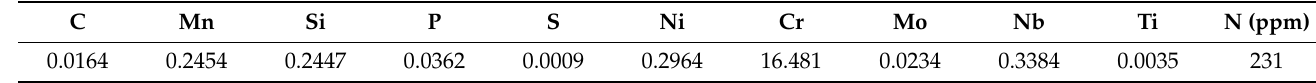
Table 1. Chemical composition of the AISI 430 steel (wt %).